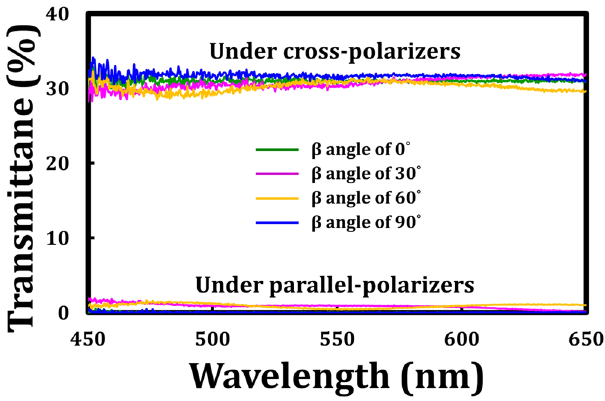
Figure 9. Measured transmission spectra of the tandem-90°-TNLC cell under cross- and parallel-polarizers when the β angles of the incident broadband backlight were 0°, 30°, 60°, and 90°. Cross- and parallel- polarizers represent that the angle made between the transmissive axes of the analyzer (output) and polarizer (input) are 90° and 0°, respectively.